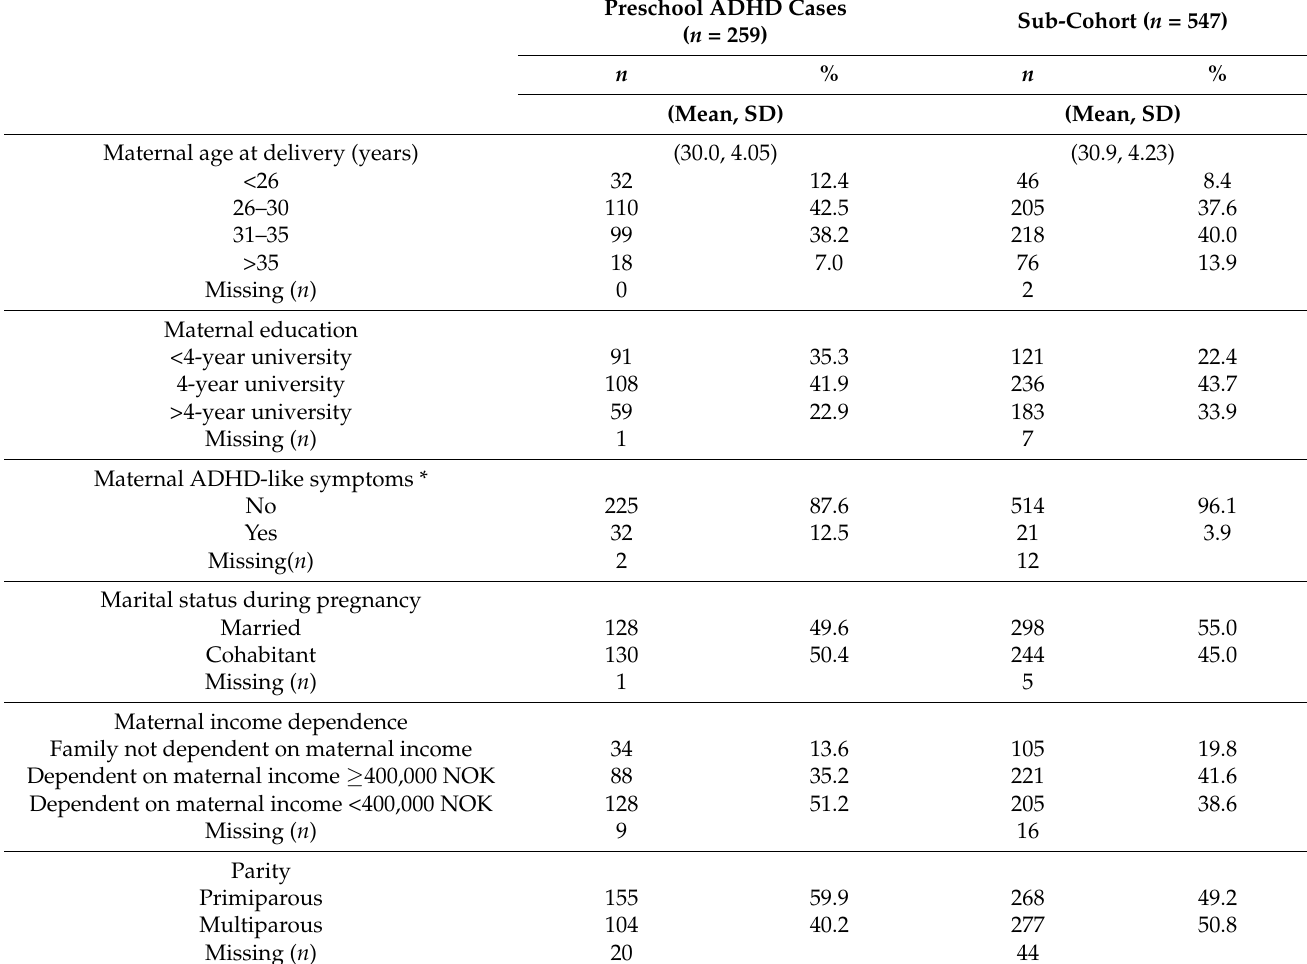
Table 1. Demographic characteristics of study population in nested case–cohort study of preschool attention-deficit hyperactivity disorder in the Norwegian Mother, Father and Child Cohort (MoBa), birth years